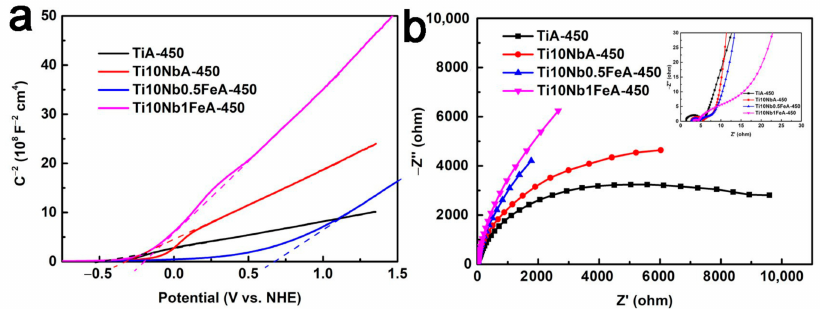
Figure 11. Mott–Schottky plots ( a ) and Nyquist plots ( b ) of the annealed TiO 2 , Ti-Nb-O and Ti-Nb- Fe-O nanotubes.